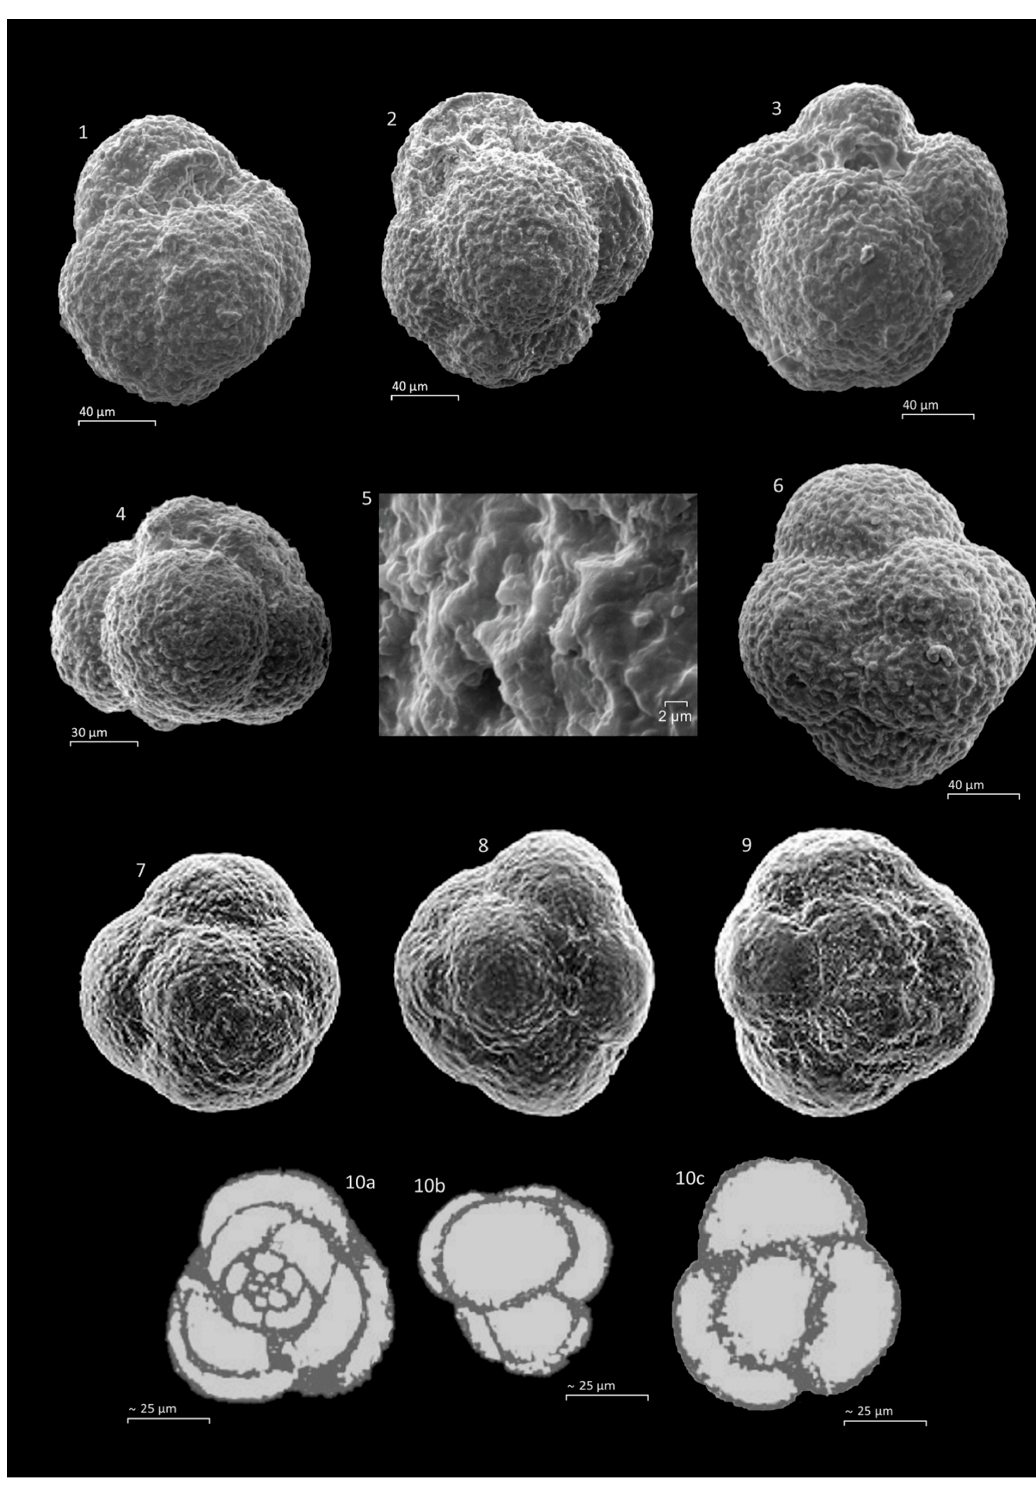
Figure A4. Conoglobigerina grigelisi (Gradstein). Subfigures 1 – 6 , holotype and paratype specimens in sample 24/2P, Tojeira Formation, Lower Kimmeridgian, Montejunto, Portugal. Globuligerina avariformis (Kasimova). Subfigures 7 – 9 . Upper Bajocian, Negramkoye Gorge, Aras River, Nakhichevan, Azerbijan; metatypes donated by Dr. Kasimova to the Natural History Museum (London, UK) diameter of 320 µ m may be an error. Subfigure 10 a – c , holotype drawing by Kasimova and Aliyeva [16] ×